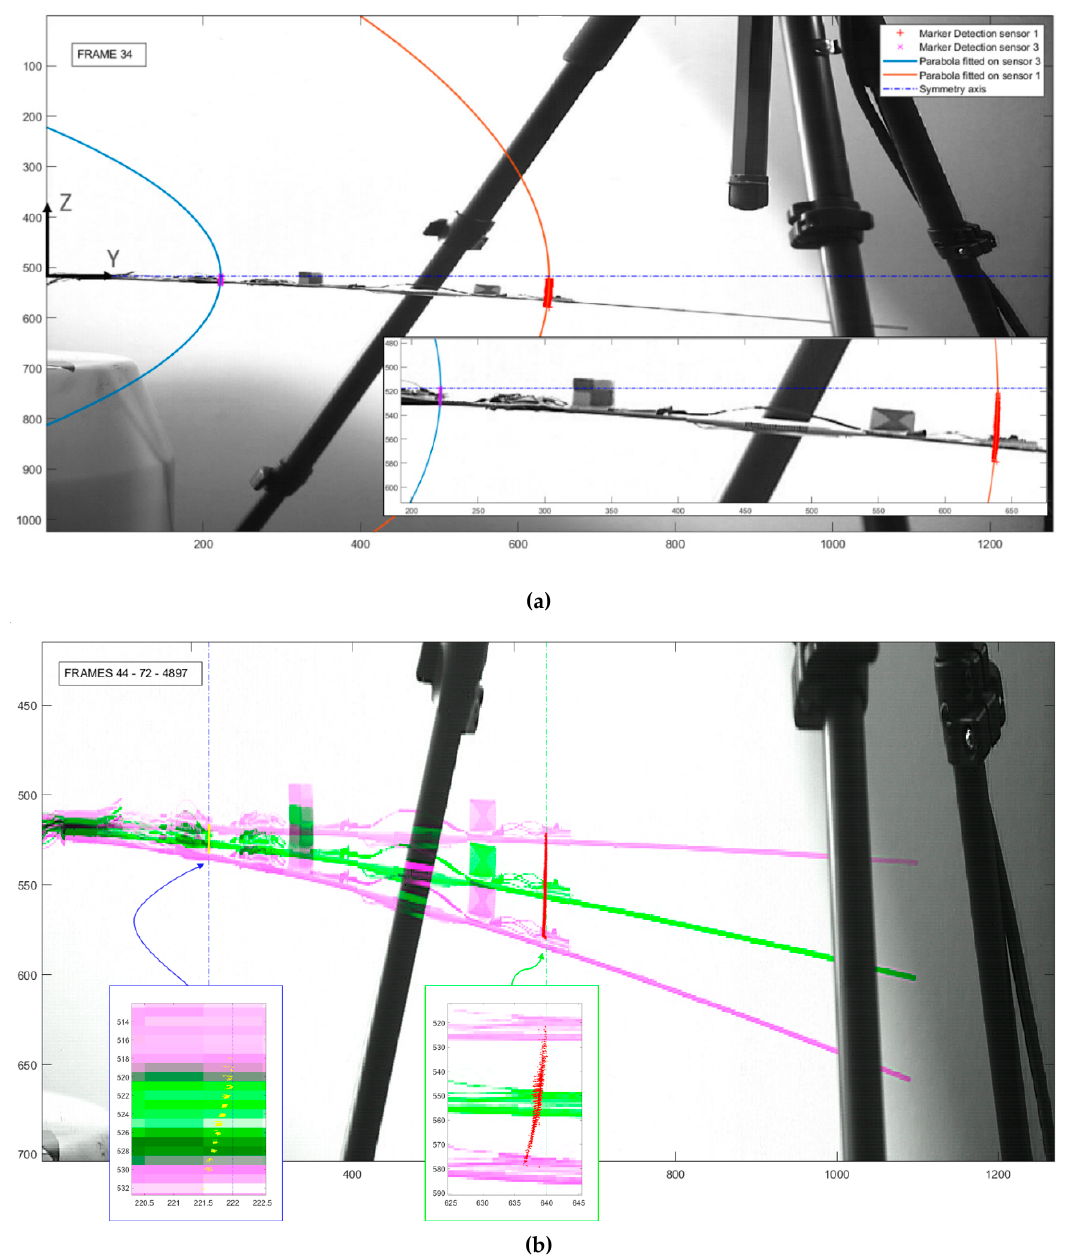
Figure 10. ( a ) Detected targets and the parabolas fitted on them (solid blue and red lines) superimposed to a general frame; the shared symmetry axis is shown as a dashed–dotted blue line. ( b ) Detected targets superimposed to the spar minimum, maximum of the deflection (pink) and to the same spar in rest condition (green). Tangent lines to the two parabolas are shown as dashed–dotted blue and green lines.